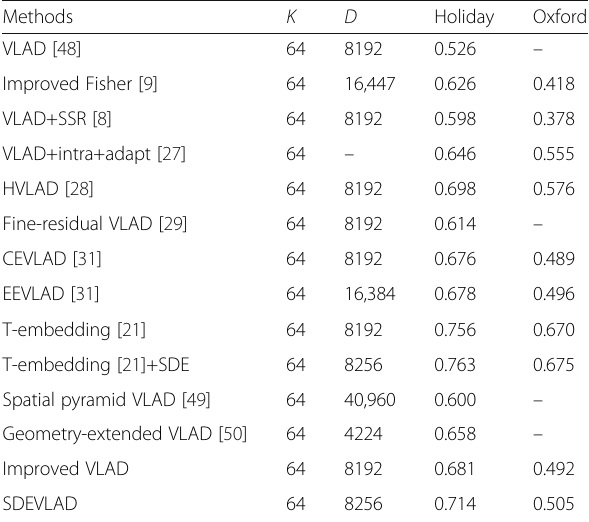
Table 2 Image retrieval task on Holidays and Oxford for full-size representation comparison